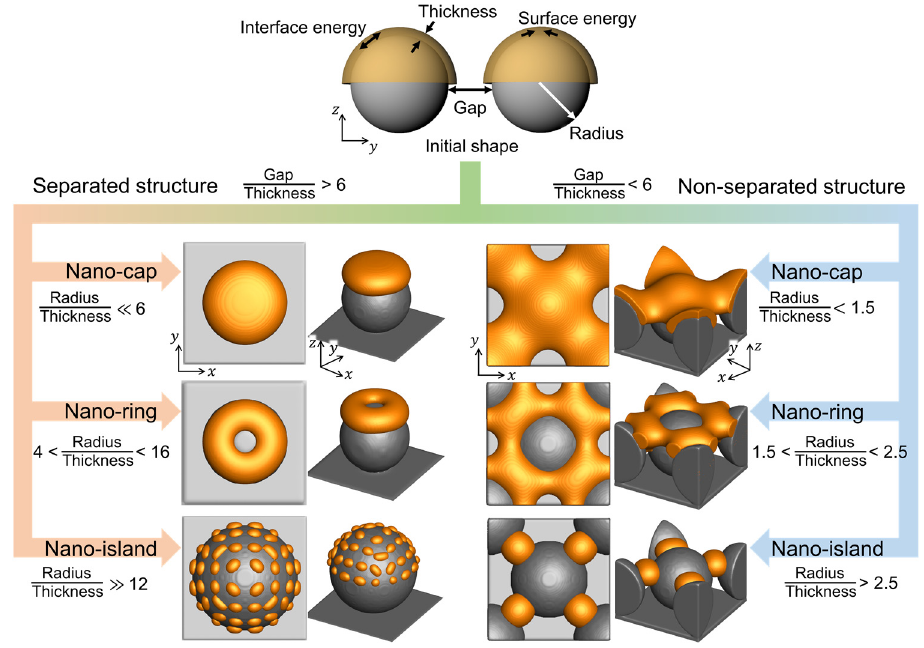
Figure 7. The equilibrium morphologies of nanostructures with respect to the gap, radius, thickness, surface energy, and interface energy.